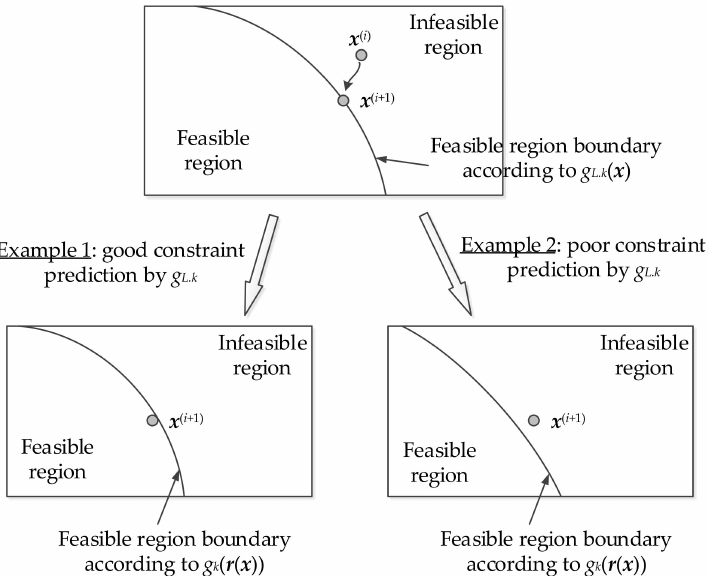
Figure 10. Prediction of constraints with the use of linear model S L.ineq.k .: ( top ) design shift from x ( i ) to x ( i +1) as a result of solving (6), the purpose of the design relocation is to minimize the footprint area and to meet the constraint (as predicted by S L.ineq.k ); ( bottom-left ) satisfactory prediction of a linear model; ( bottom-right ) poor prediction and infeasible new design (as assessed by the true constraint value rendered by EM analysis), so, d ( i ) is to be reduced in the next iteration.